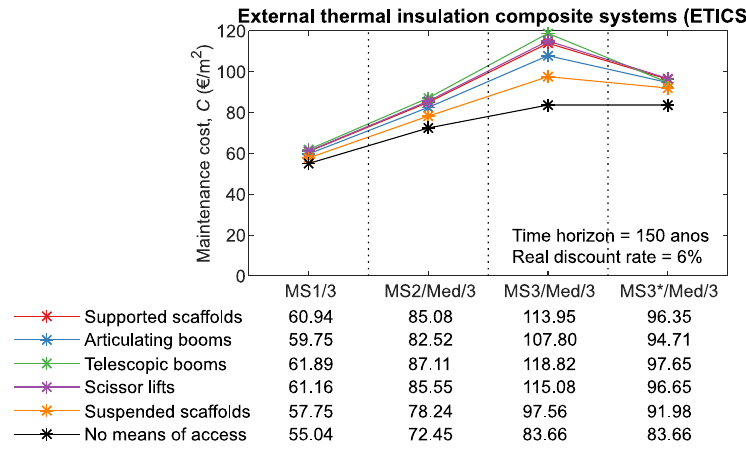
Figure 6. Sensitivity analysis of the different means of access in ETICS maintenance strategy costs for a time horizon of 150 years.